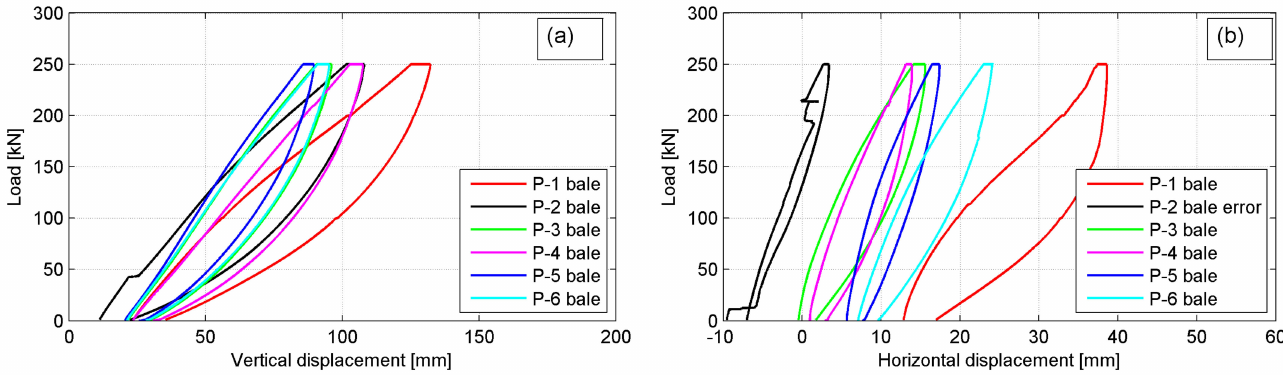
Figure 12. Average displacement plots for all bales under load p = 250 kN: ( a ) vertical displacements; ( b ) horizontal